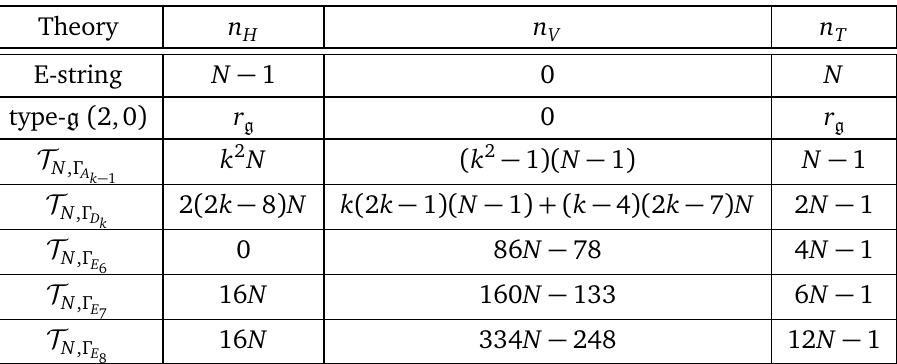
Table 1: Field content on the tensor branch of various theories.